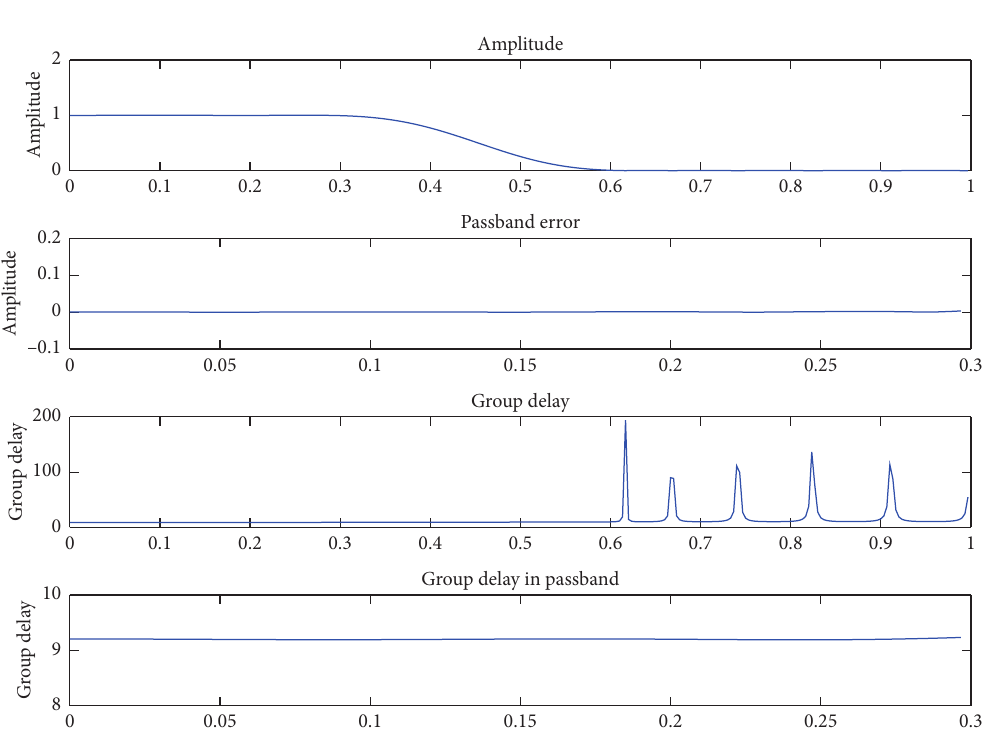
Figure 2: Performance of model reduction FIR filter for example